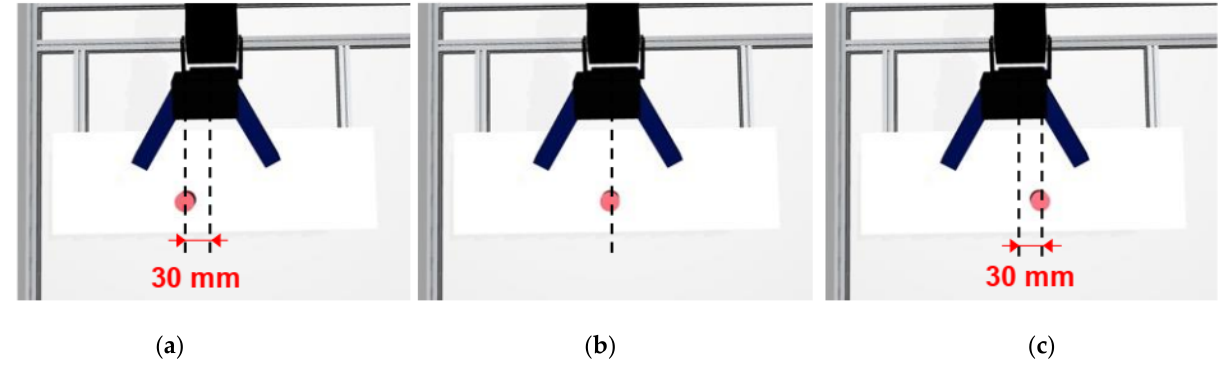
Figure 4. Variation in the initialization position of the grasping target. ( a ) Left. ( b ) Center. ( c ) Right.